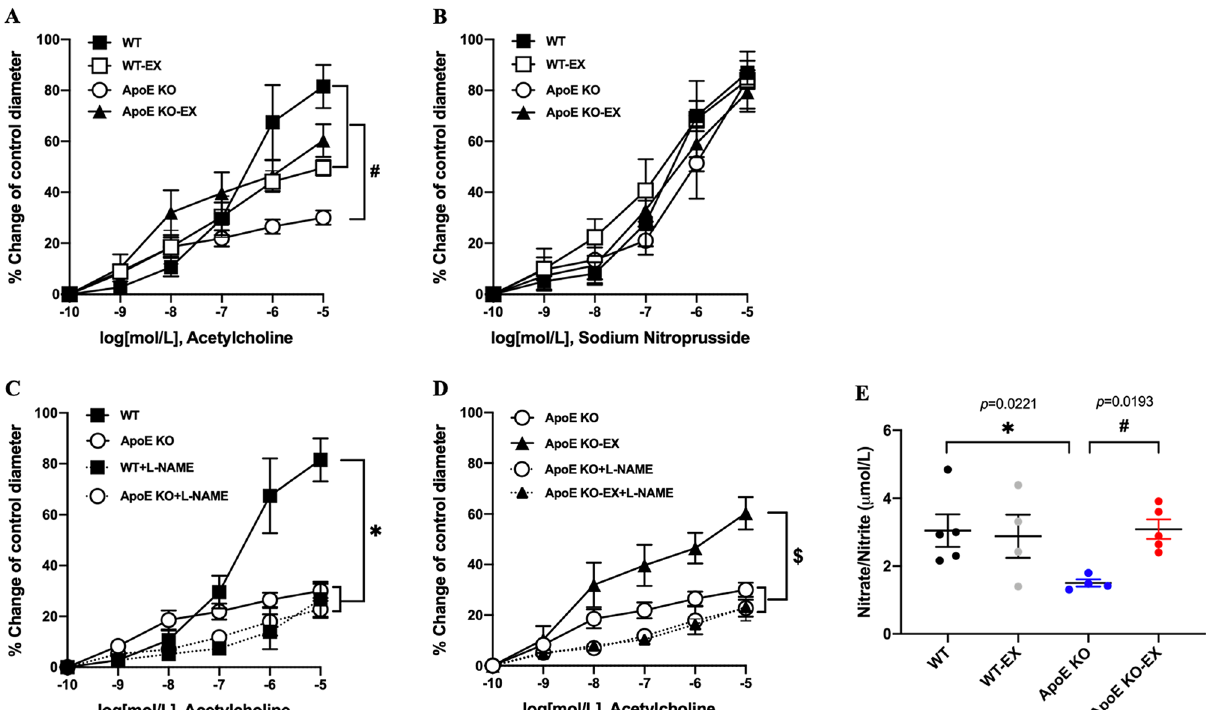
Figure 1. Effect of exercise training on endothelial dysfunction and NO production in ApoE KO mice. ( A ): Isolated coronary arterioles from WT (n = 4), WT-EX (n = 4), ApoE KO (n = 5), and ApoE KO-EX (n = 4) were measured the response of ACh in a dose-dependent manner. ( B ): Endothelium-independent vasodilation was measured in isolated coronary arterioles from WT + SNP (n = 5), WT-EX + SNP (n = 4), ApoE KO + SNP (n = 5), ApoE KO-EX + SNP (n = 4). ( C , D ): ACh-induced vasodilation in coronary arterioles was measured in the presence of L-NAME, the eNOS inhibitor, from WT + L-NAME (n = 4), WT-EX + L-NAME (n = 4), ApoE KO + L-NAME (n = 5), and ApoE KO-EX + L-NAME (n = 4). ( E ): Total nitrate/nitrite concentration was analyzed in mice heart from each group (n = 4–5/groups). Values are means ± SEM. * p < 0.05 versus WT, # p < 0.05 versus ApoE KO, § p < 0.05 versus ApoE